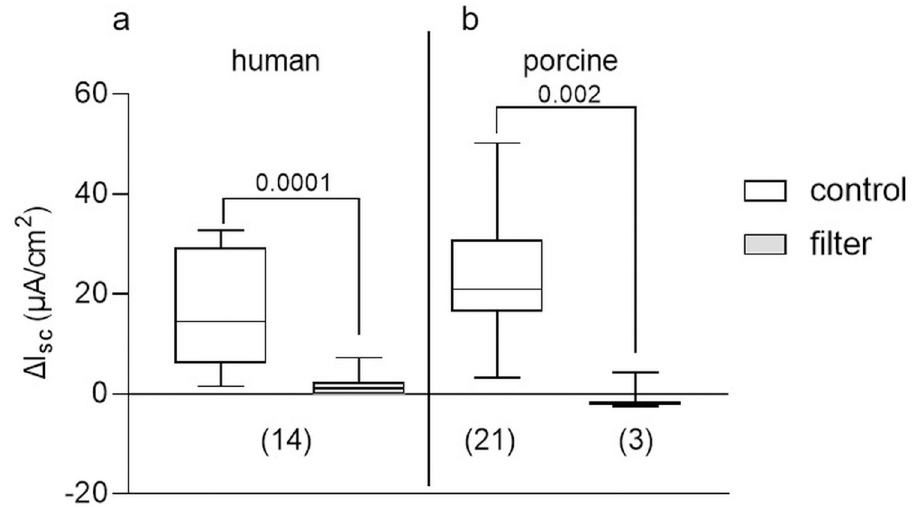
Fig 8. Secretory response to tensile forces. Prevention of tissue distension during P ser by a mucosal placed filter significantly reduced the secretory response in human ((a); Wilcoxon test) and porcine (b) colonic tissue (unpaired t test); p values above brackets. Data shown are the medians with the 25 th and 75 th quartiles as a box plot and the minima and maxima as a whisker plot. N numbers are given in parenthesis.